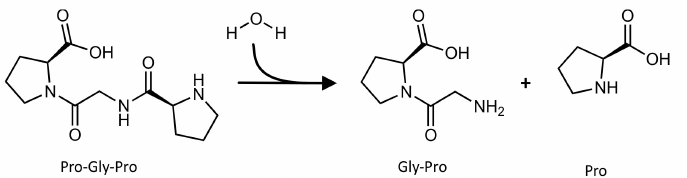
Figure 10. Schematic representation of the reaction catalyzed by the aminopeptidase activity of the LTA 4 H